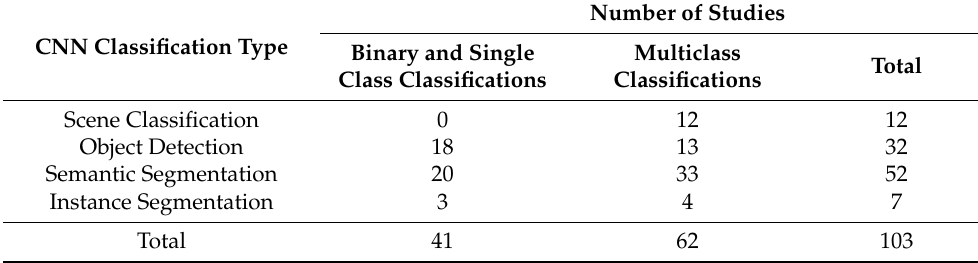
Table 3. Studies surveyed in the literature review by CNN classification type. Of the 100 papers that were surveyed, three papers each had two studies of different types, resulting in a total of 103 studies